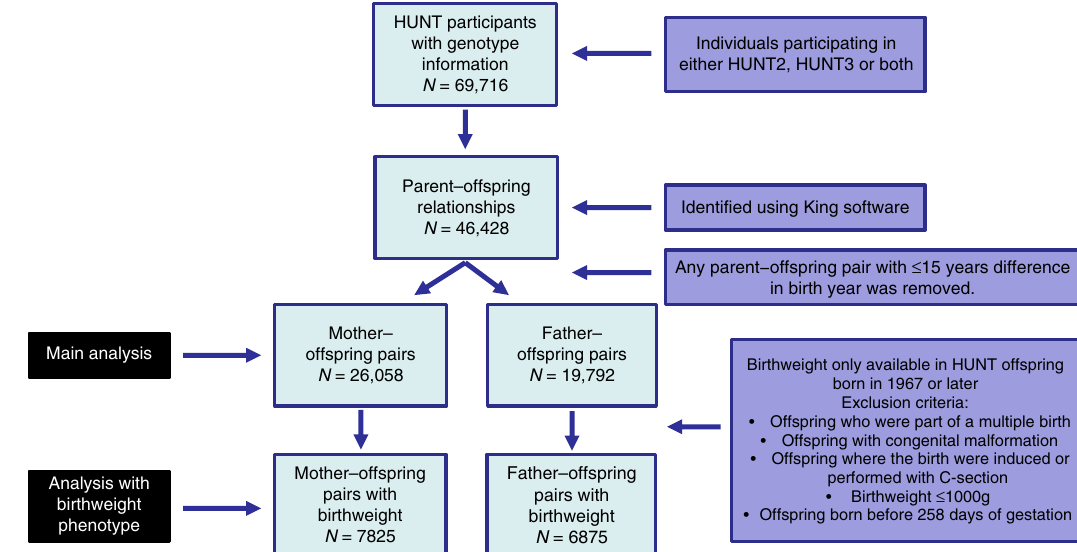
Fig. 3 Flowchart showing the number of individuals ( N ) participating in the analysis and the exclusion criteria for each analysis. A total of 69,716 genotyped HUNT participants were recruited from either HUNT2 or HUNT 3. Of these 46,428 parent – offspring relationships were identi fi ed using the King software. Parent – offspring pairs with ≤ 15 years difference in birth year were removed leaving 26,058 mother – offspring pairs and 19,792 father – offspring pairs for the main analysis. Birthweight was only available for offspring born after 1967. Additionally, for analyses involving birthweight as an outcome, offspring were excluded if they were part of a multiple birth, had congenital malformation, were born where the birth was induced or performed with C- section, their birthweight ≤ 1000 g, or were born before 258 days of